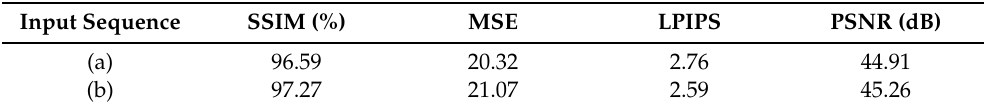
Table 4. Quantitative results on two